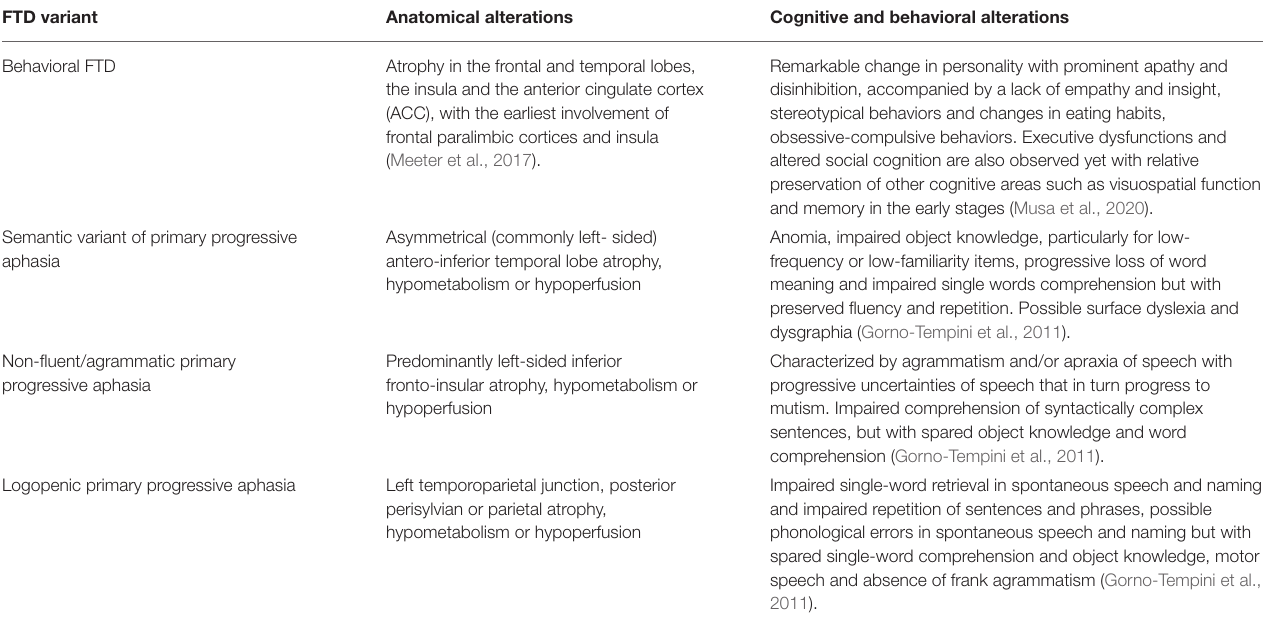
TABLE 1 | Summary of anatomic, cognitive, and emotional/behavioral alterations observed in the FTD